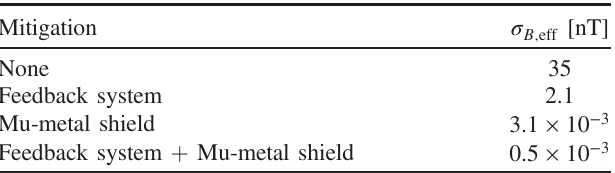
TABLE II. Standard deviation of the stray field σ B; different mitigation techniques.